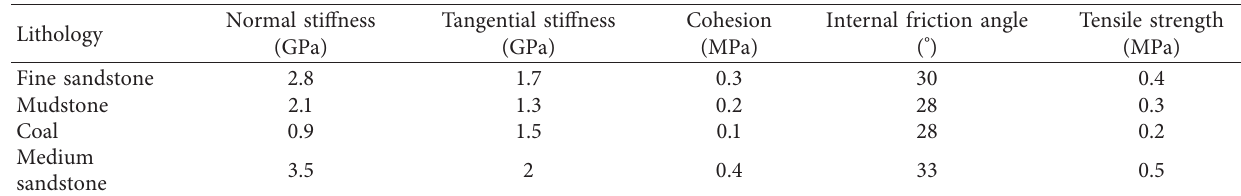
Table 5: Mechanical parameters of